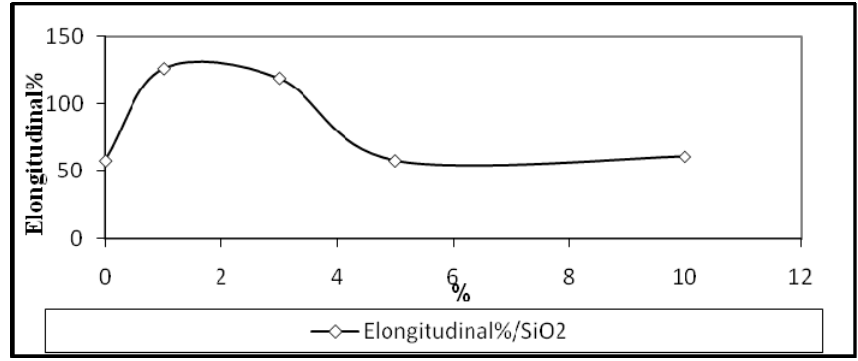
Fig. 2: Change in elongitudinal % with the silica compositions.